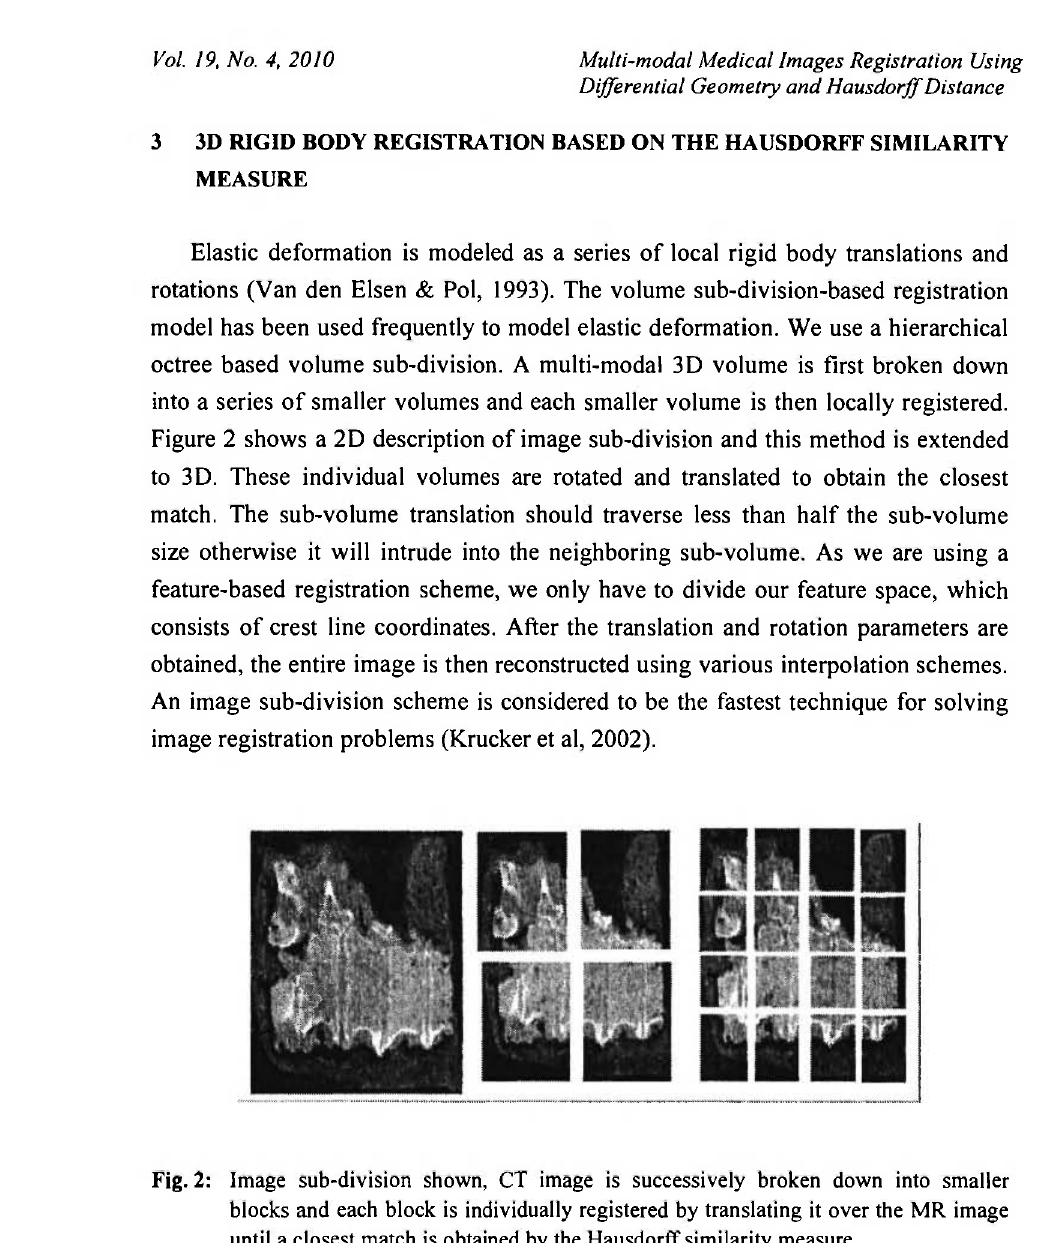
Fig. 2: Image sub-division shown, CT image is successively broken down into smaller blocks and each block is individually registered by translating it over the MR image until a closest match is obtained by the Hausdorff similarity